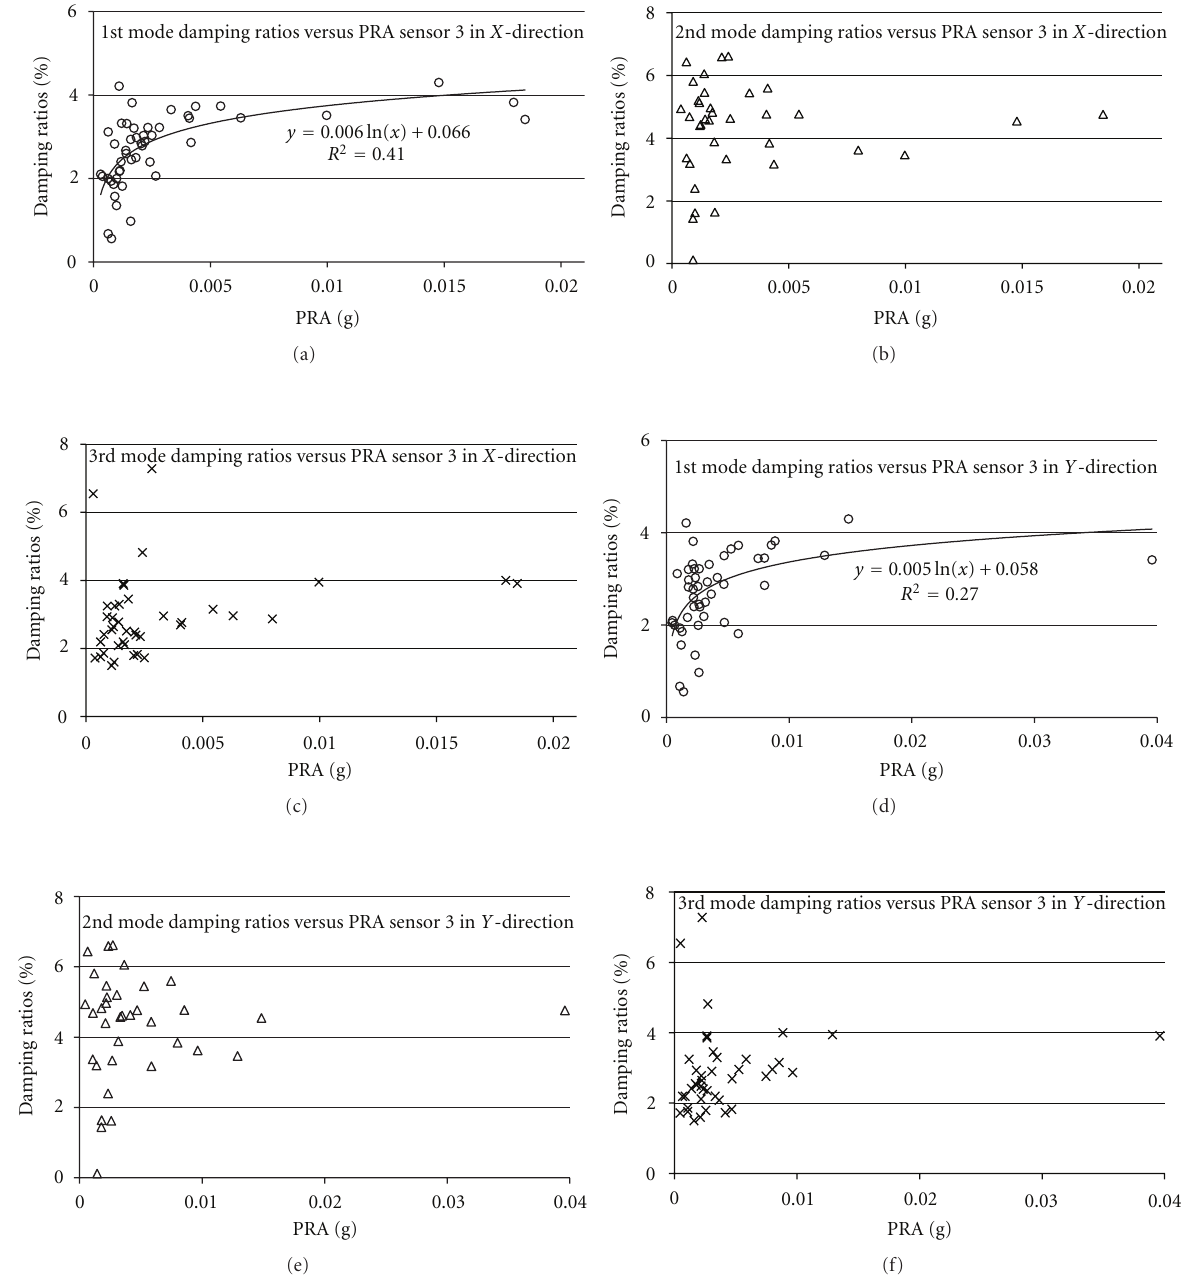
Figure 15: Modal damping ratios of building A for pseudoflexible base case: (a) 1st mode, (b) 2nd mode, (c) 3rd mode versus X -direction PRA of sensor 3; (d) 1st mode, (e) 2nd mode, and (f) 3rd mode versus Y -direction PRA of sensor